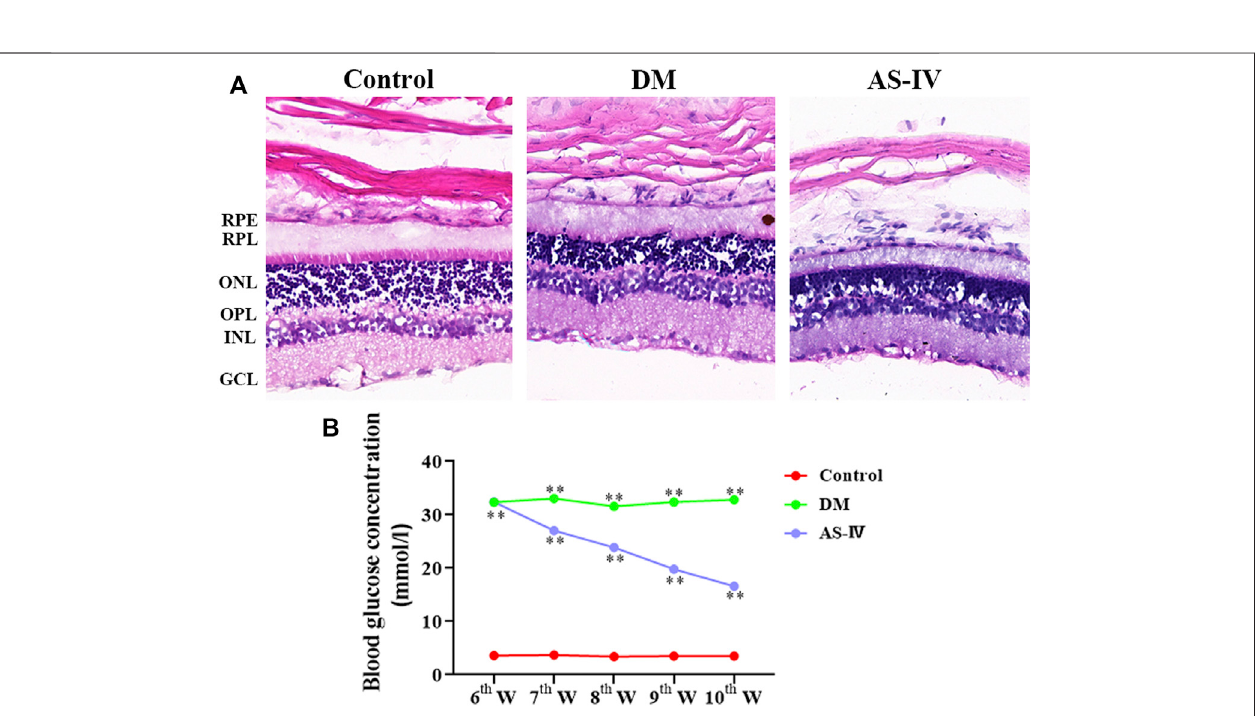
Frontiers in Pharmacology |